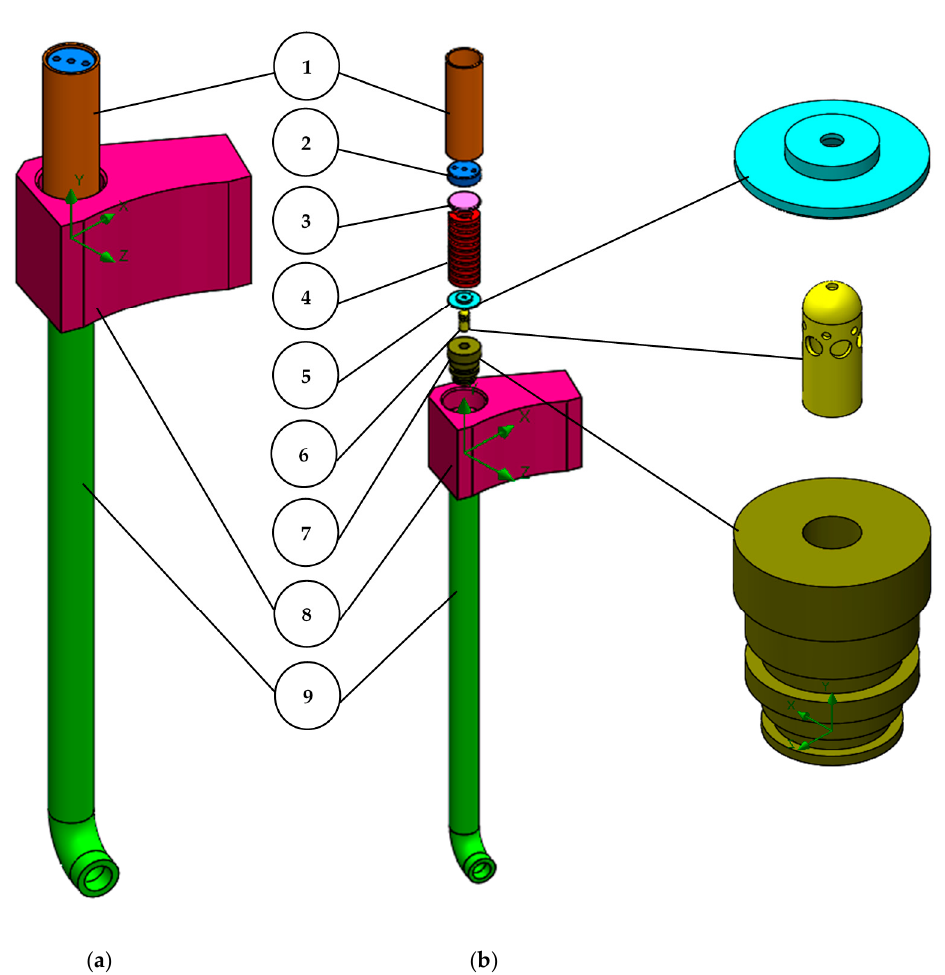
Figure 5. 3D view of the analyzed safety elements: ( a ) – assembly view, ( b ) – exploded view, 1– adjusting nut cover, 2– adjusting nut, 3– adjusting nut shield, 4– spring, 5– piston disc, 6– slide piston, 7– connecting spigot, 8– connection block, 9– pipe.